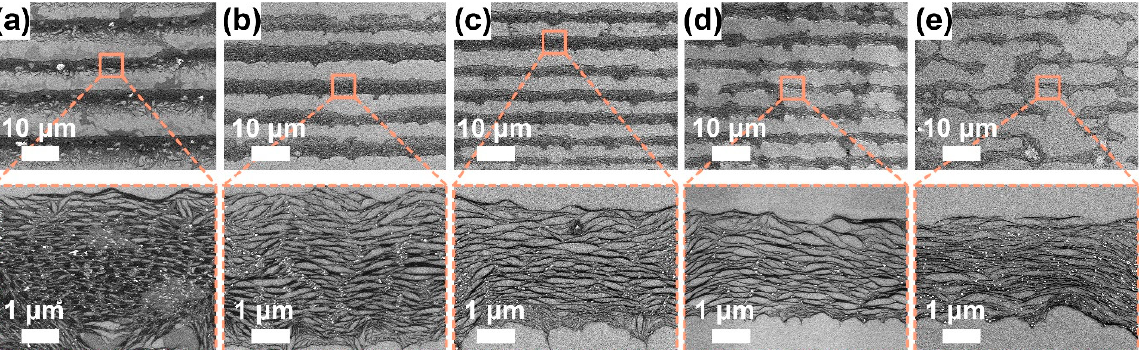
Figure 4. SEM images for P3-SWCNT films at a fixed SDS concentration (~1.0 mg/mL), withdrawal speed (0.1 μ m/s), environment temperature (~17 °C) and humidity (~50–70%), but varied SWCNT concentrations: ( a ) ~70.0, ( b ) ~25.0, ( c ) ~14.0, ( d ) ~9.3, and ( e ) ~7.0 μ g/mL. To characterize the alignment of SWCNTs in stripes, high-resolution SEM images were shown below.